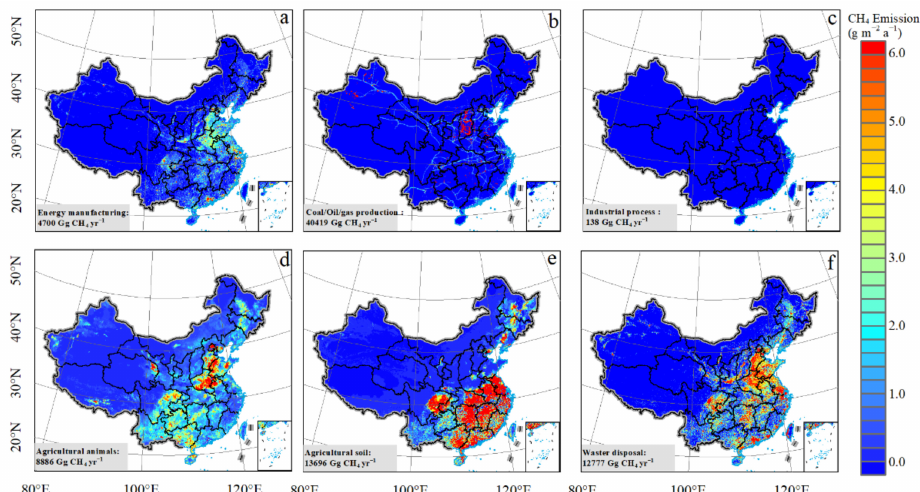
Figure A1. Spatial distribution of the annual mean of CH 4 emission of six categories from EDGAR over China during 2003–2018 (g m − 2 a − 1 ). ( a ) Energy manufacturing (including public electricity and heat production, petroleum refining, manufacture of solid fuels and other energy industries, mobile, solid fuel transformation, distribution of oil products, natural gas, iron and steel production, manufacturing industries and construction (ISIC), civil aviation, road transportation, railways, other transportation, navigation, and other sectors); ( b ) coal/oil/gas production (including coal mining, oil exploration, oil production, oil transport, oil refining/storage, venting, and flaring); ( c ) indus- trial process (including chemical industry, iron and steel production, and ferroalloys production); ( d ) agricultural animal (including enteric fermentation and manure management); ( e ) agricultural soil (including rice cultivation, agricultural soils, and field burning of agricultural residues); ( f ) waste disposal (including solid waste disposal on land, waste incineration, and wastewater handling).